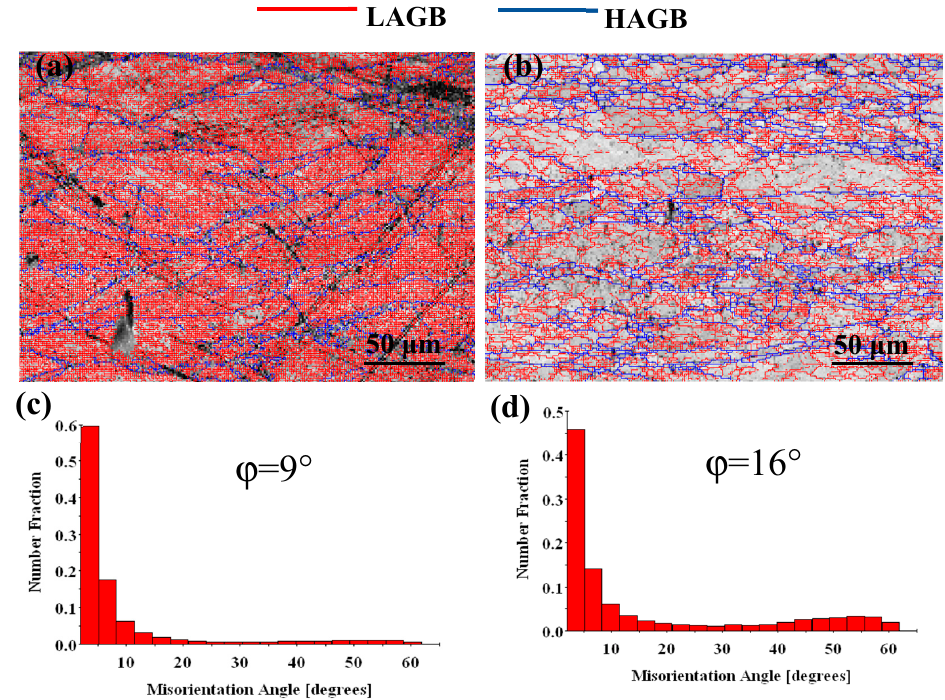
Figure 6. Orientation maps and misorientation angle distributions of the Cu-Ni-Co-Si-Cr alloy deformed at: ( a , c ) 600 ◦ C, 0.001 s − 1 ; ( b , d ) 900 ◦ C, 0.001 s − 1 . HAGBs are shown as blue lines, and LAGBs are shown as red lines. ϕ : The average misorientation angle.